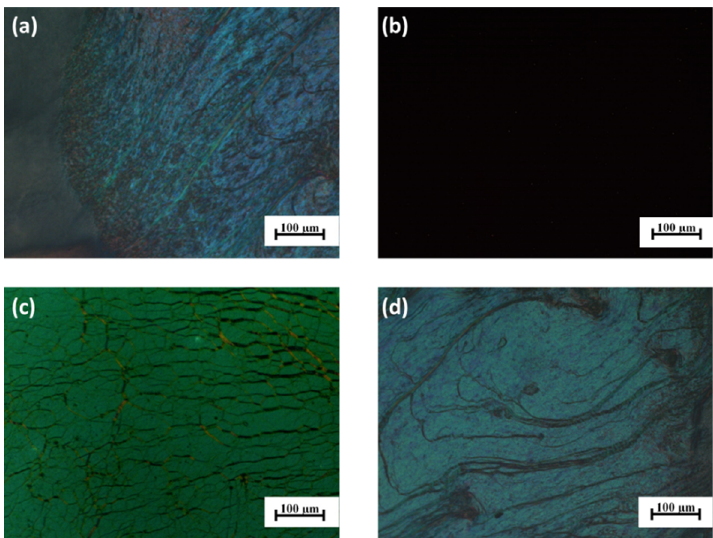
Figure 2. Polarized optical microscopic images of sample 3HG8020: ( a ) at 45 °C; ( b ) at 165 °C; ( c ) at 150 °C; ( d ) at 25 °C.